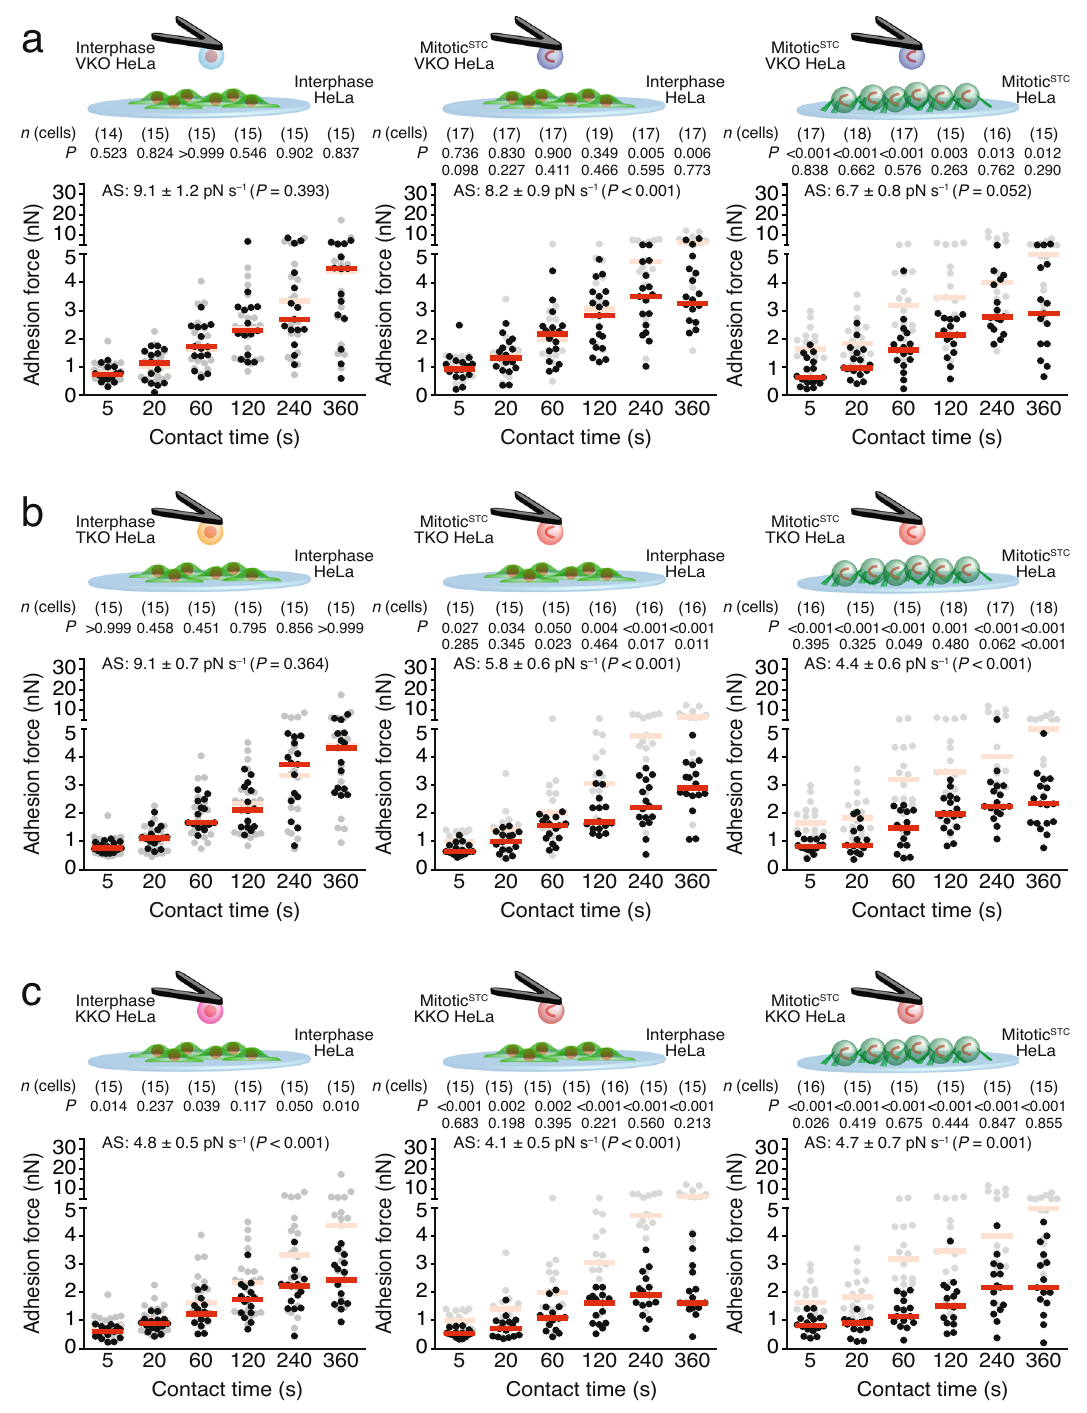
Fig. 4 | Integrin adhesome proteins differently regulate cell – cell adhesion in interphase and mitosis. Cell – cell adhesion forces between VKO ( a ), TKO ( b ), or KKO ( c ) HeLa cells and wildtype HeLa cells spread on a Matrigel-coated substrate after given contact times. Panels show adhesion forces of interphase KO and interphase wildtype (left), mitotic STC KO and interphase wildtype (middle) or mitotic STC KOandmitotic STC wildtypeHeLacells(right).AS-valuesgivetheadhesion strengthening rate as the slope (±SE) of a linear fi t through adhesion forces for all contact times with the P value comparing the AS -value to the reference data (SupplementaryFig.9).Asreferencecell – celladhesionforcesestablished between